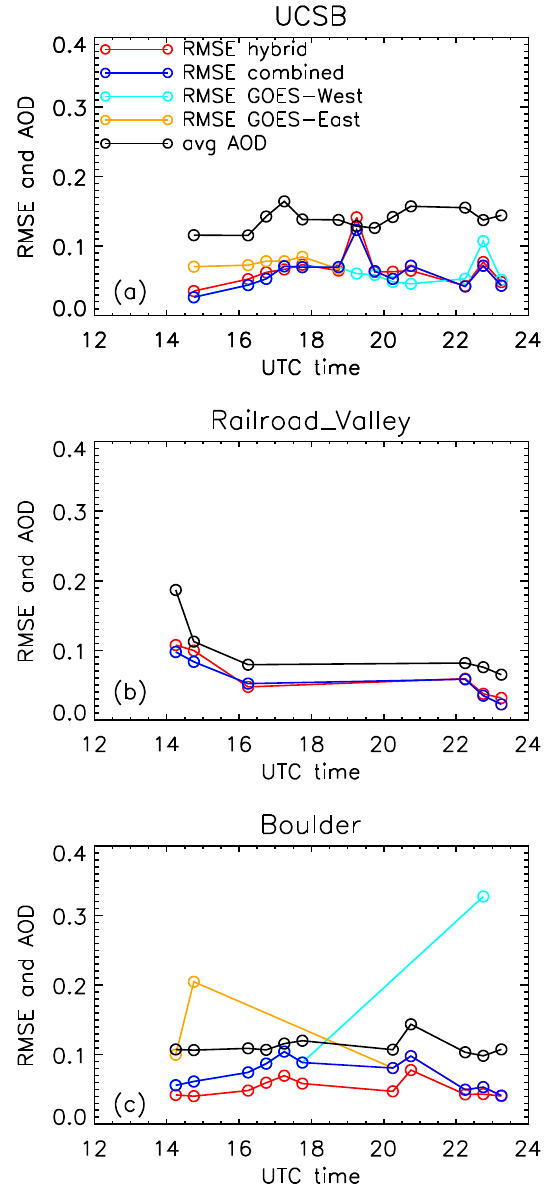
Fig. 8. Diurnal variation of RMSE in GOES AOD retrievals for the four algorithms along with the average AERONET AOD.